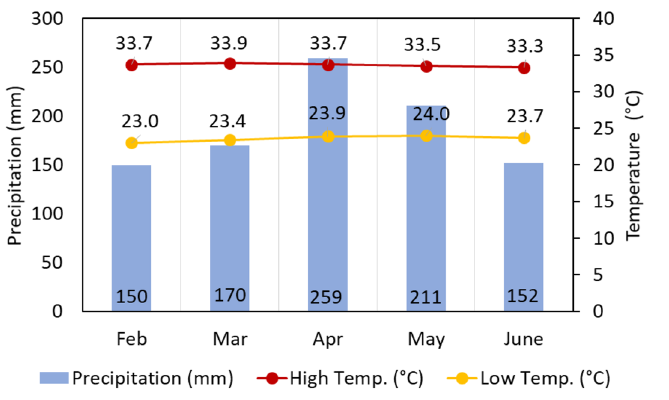
Figure 4. Weather conditions recorded throughout the